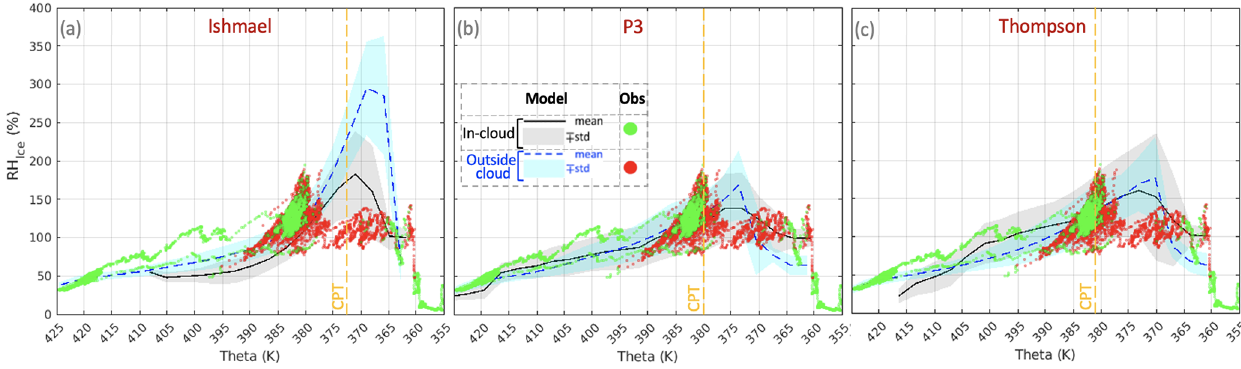
Figure 12. Relative humidity with respect to ice versus potential temperature in clouds and outside clouds from observations (red and green) and simulations (gray and blue) using the ISHMAEL (a) , P3 (b) , and Thompson (c) schemes. The vertical dashed orange line represents the level of cold point temperature